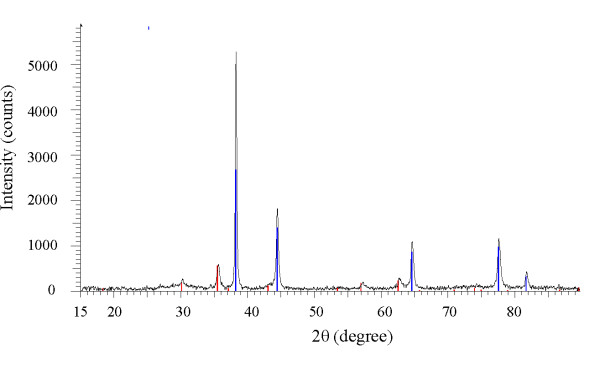
XRD pattern of Core-shell Fe3O4-gold nanoparticles with 15 nm diameter.